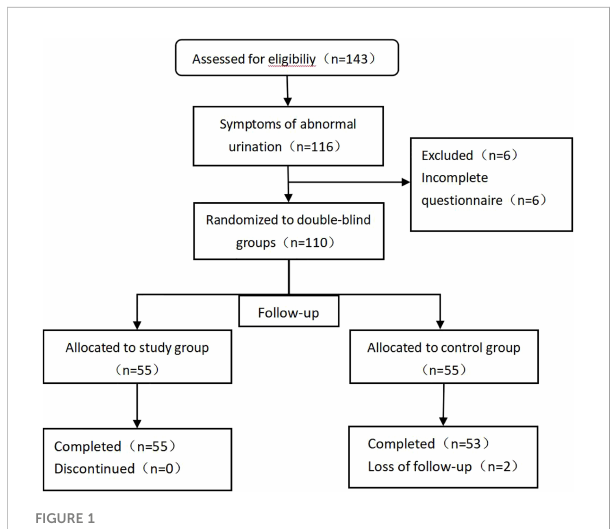
FIGURE 1 Flowchart for patients